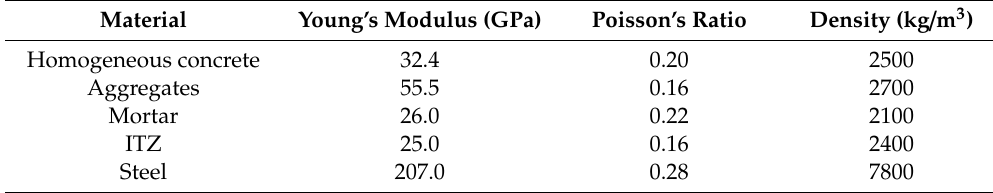
Table 1. Material properties of the concrete core and steel tubular of CFST.